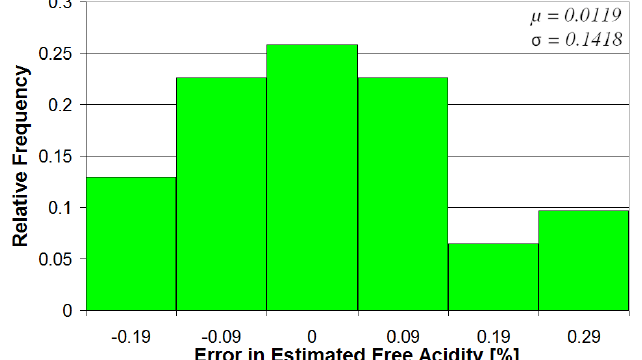
Figure 6. Histogram for the error in the estimated free acidity in the case of fresh samples (i.e., samples featuring a peroxide index < 20 meq O 2 /kg).